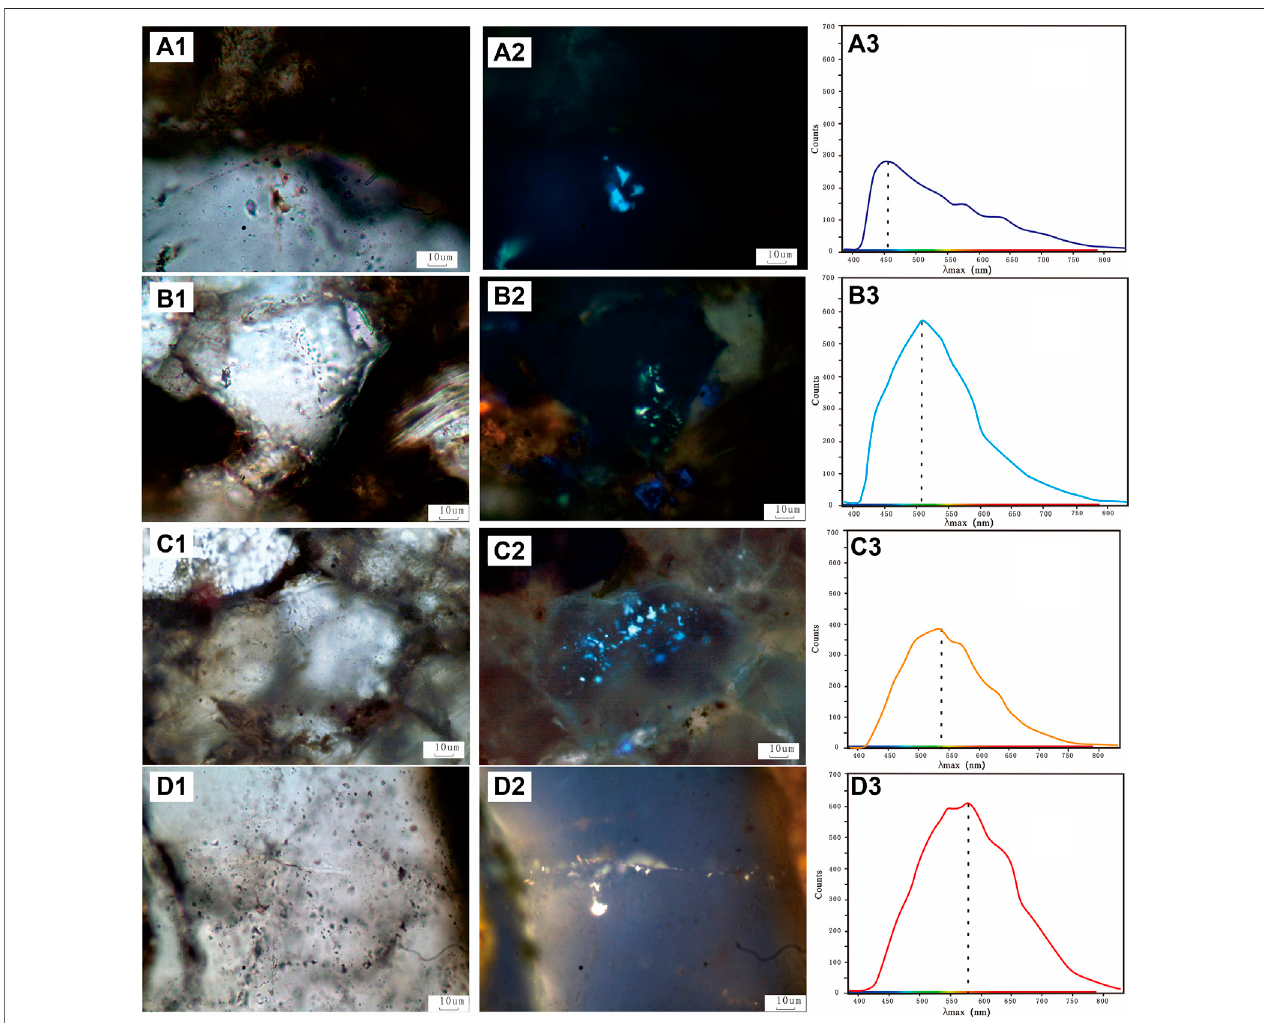
FIGURE 3 | Fluorescent color and microscopic fl uorescence spectra of oil inclusions in the Fuyu oil reservoir of the Sanzhao area.